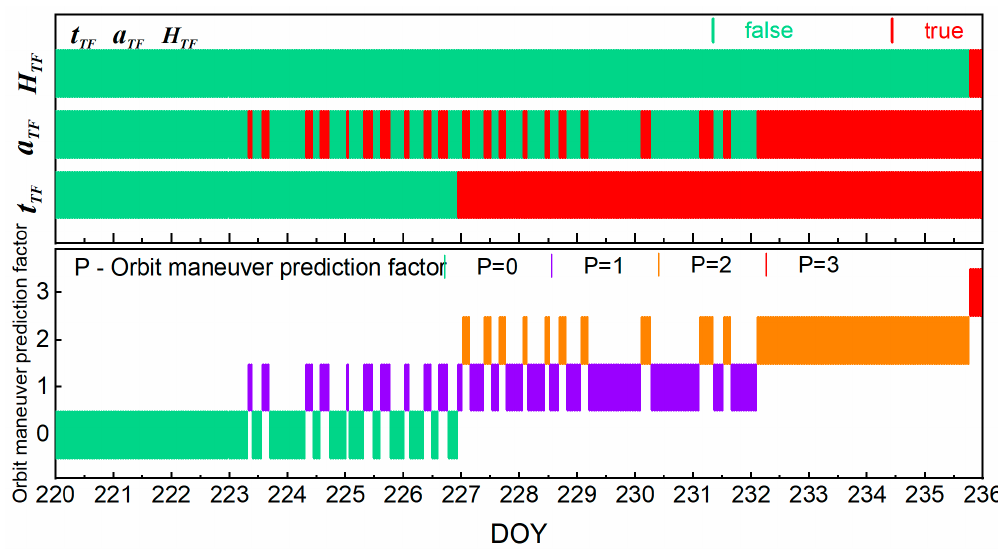
Figure 7. Orbit maneuver prediction factors for C07 satellite.